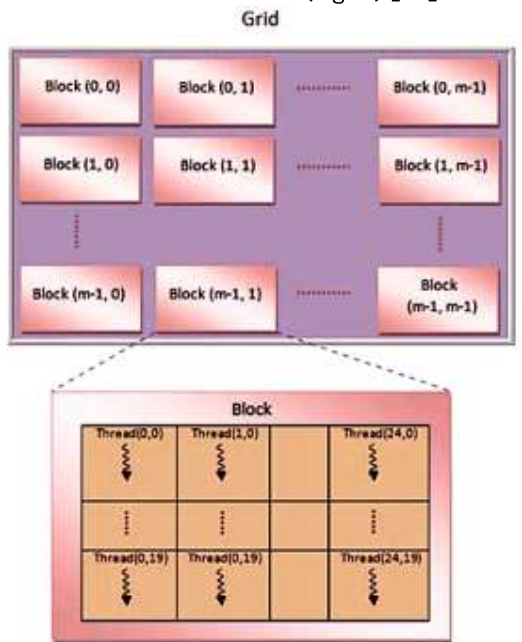
Figure 8. Grid configuration for calculating hamming distance with GPUs.